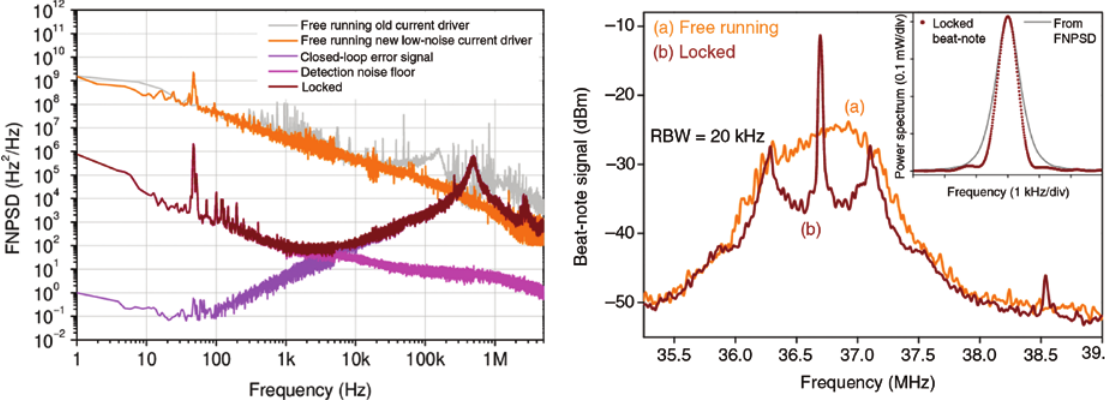
Figure 4: QCL FNPSDs (free-running and locked) and beat note with the DFG source. Left: Comparison between the free-running QCL FNPSDs and the locked one. The locked QCL FNPSD is obtained by summing the spectrum of the closed-loop error signal to the PS detection noise floor, measured with empty gas cell. Right: FFT spectra of a 10-ms-long evolution of the beat note between the QCL, in free-running (trace a) and locked (trace b) conditions, and the narrow DFG source. Inset: zoomed view (linear scale) of the central peak observed over 1 ms with a resolution bandwidth of 721 Hz (dotted curve) and QCL power spectral profile retrieved from the locked FNPSD (straight line). Reprinted with permission from [51], copyright